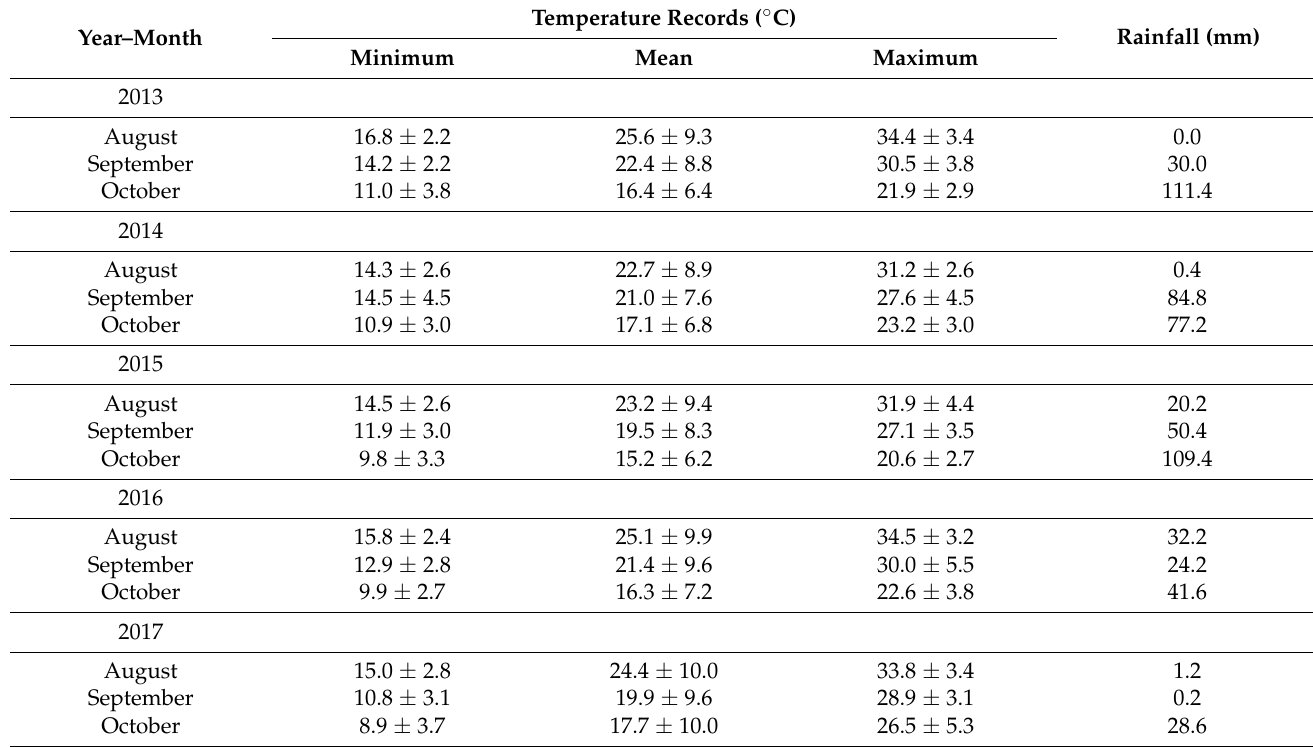
Table 2. The mean temperature ( ◦ C) (minimum, mean, and maximum) and total rainfall (mm) in the months of August, September, and October of Mirandela region (northern Portugal) over five years